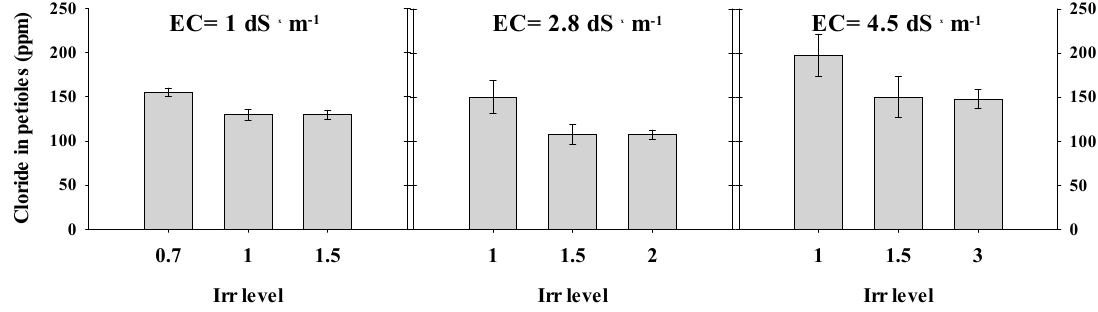
Figure 2. Chloride concentration in the petioles of pepper, treated with combinations of various salinities and irrigation (Irr) levels. Measurements were conducted in December 2015. Error bars indicate standard deviation (n = 4).